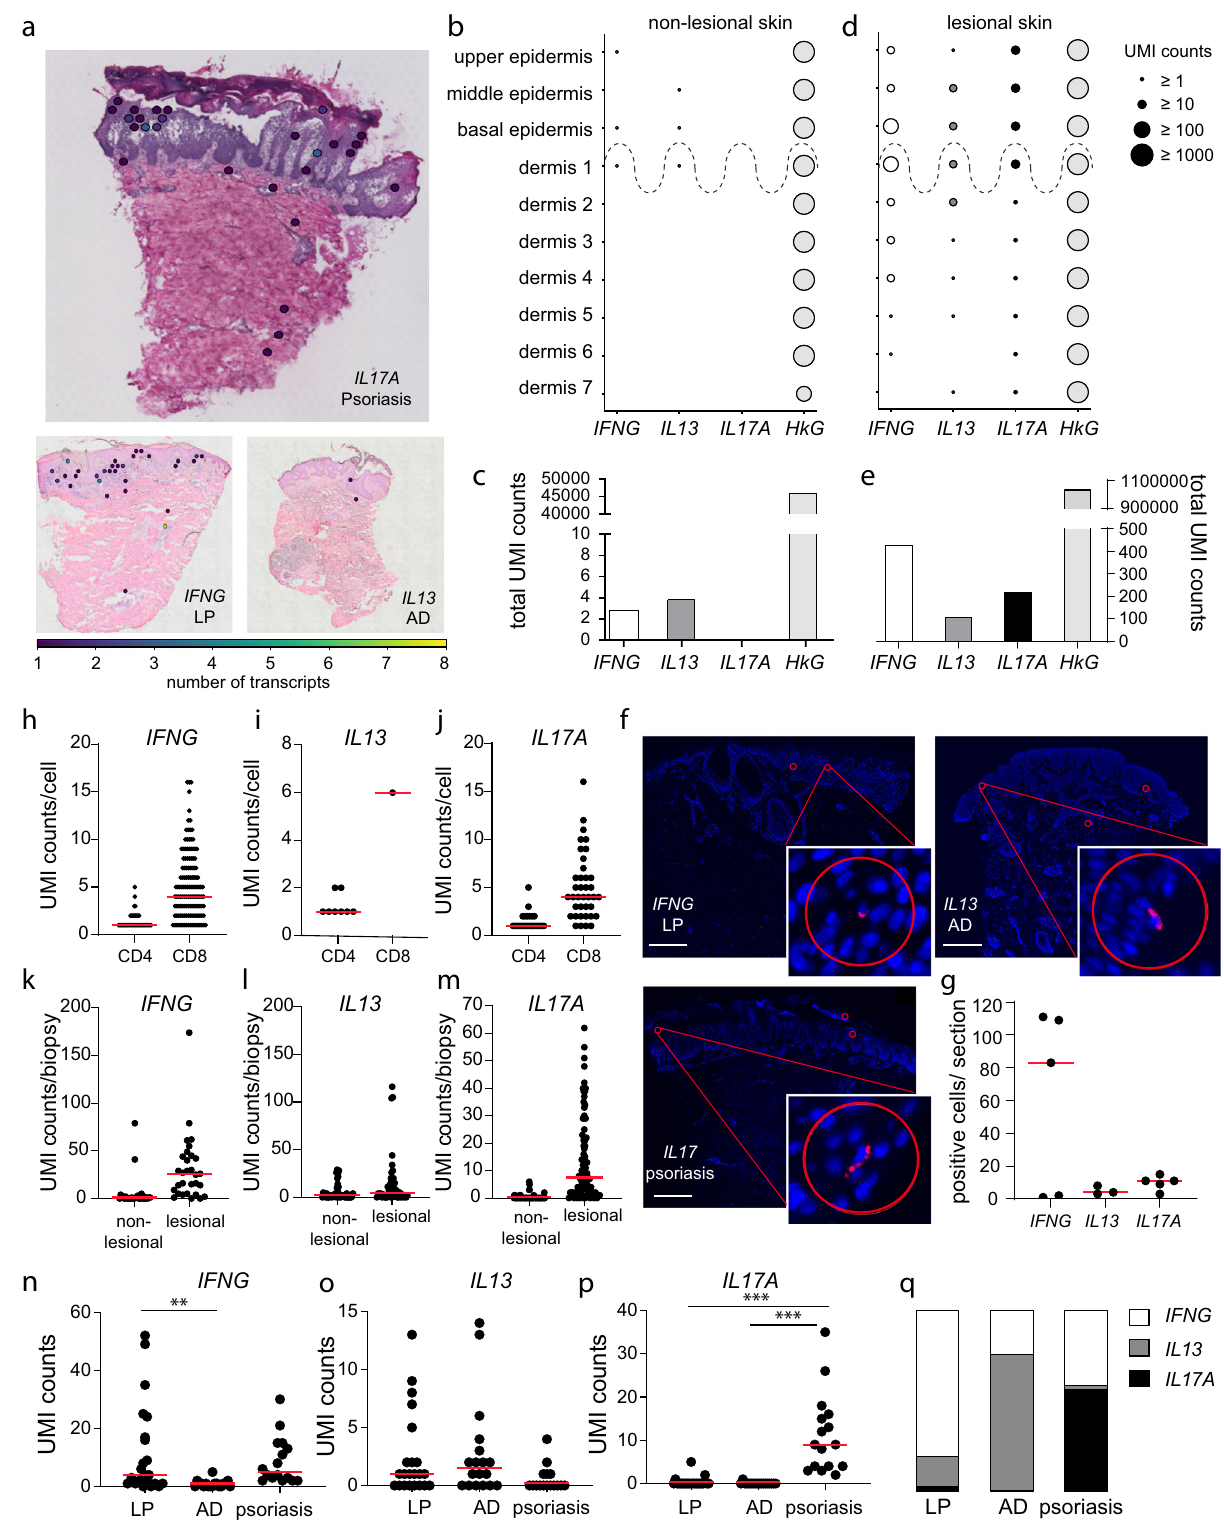
(Fig. 4b, Supplementary Fig. 6a). DEG analysis of cytokine transcript- positive versus cytokine transcript-negative leukocytes further con- fi rmed the spatially determined expression of immune cell derived genes onsingle-celllevel.However, response signatures that cytokines induce in tissue cells were widely missing in the single-cell leukocyte fraction as these genes were either not detected or found below sta- tistical signi fi cance (Fig. 4c). This comparison, however, also